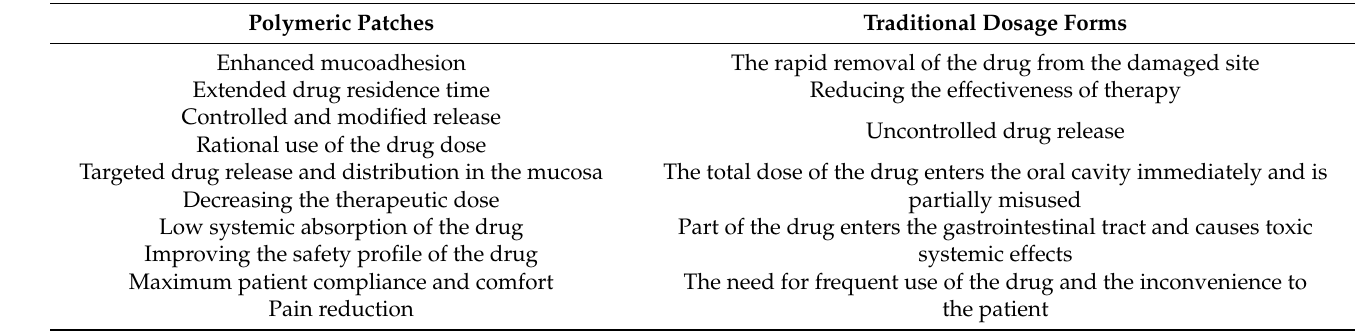
Table 1. Comparative characteristics of polymeric patches and traditional dosage